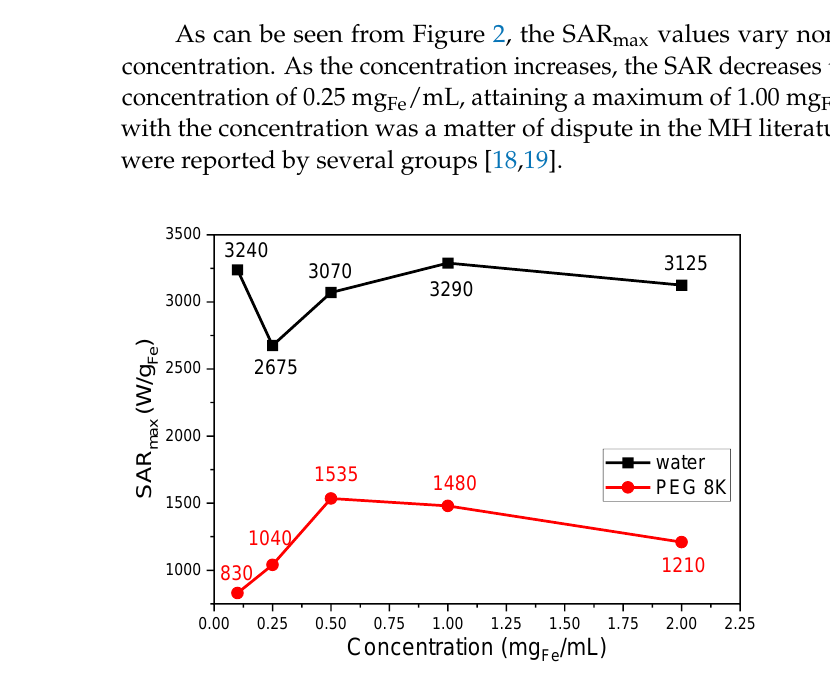
Table 2. SAR max , H cHyp, and n for the samples measured in water and PEG 8K.